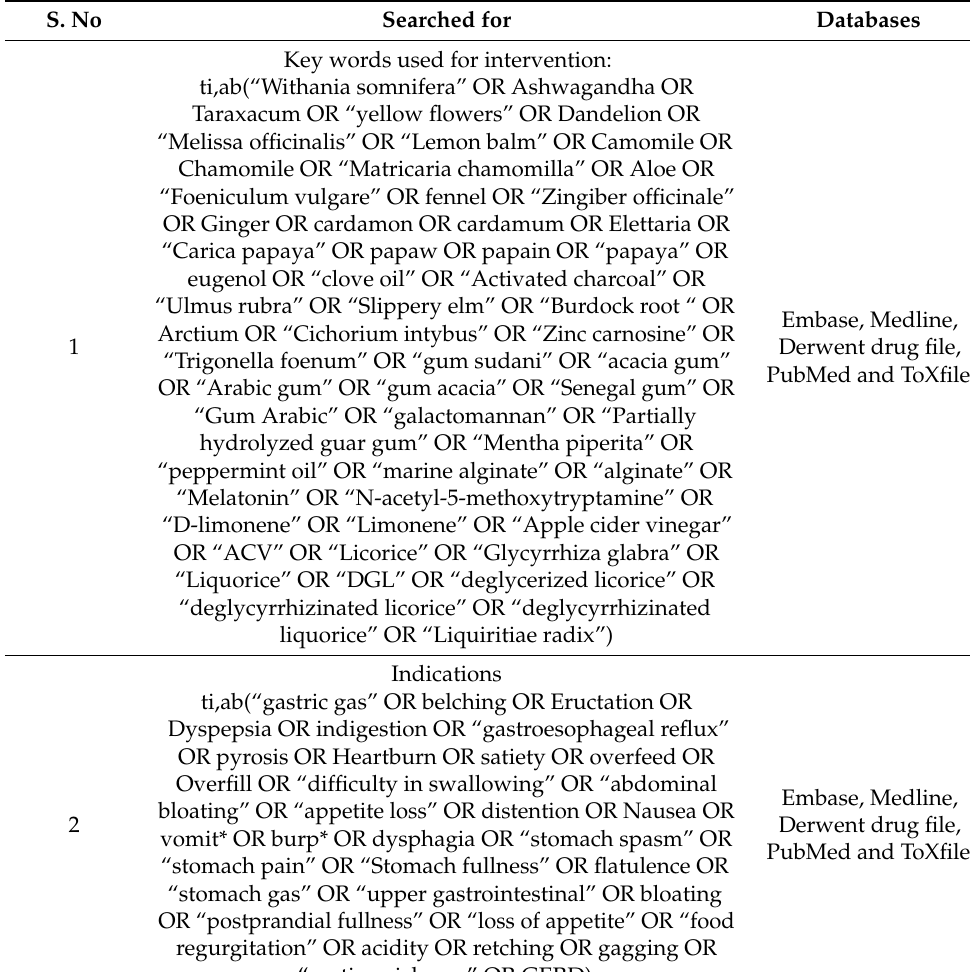
Table 3. Search string for nutritional ingredients and upper GI conditions and